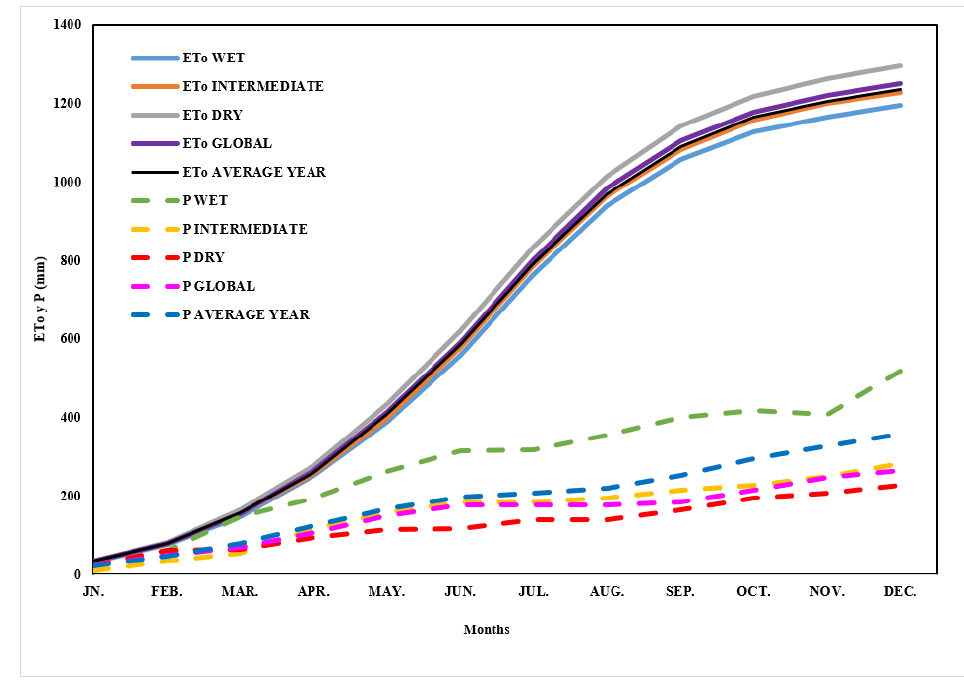
Figure 3. Cumulative daily evolution of reference evapotranspiration (ET o ) and precipitation (P) for average year and typical meteorological years (global, dry, intermediate, and wet).